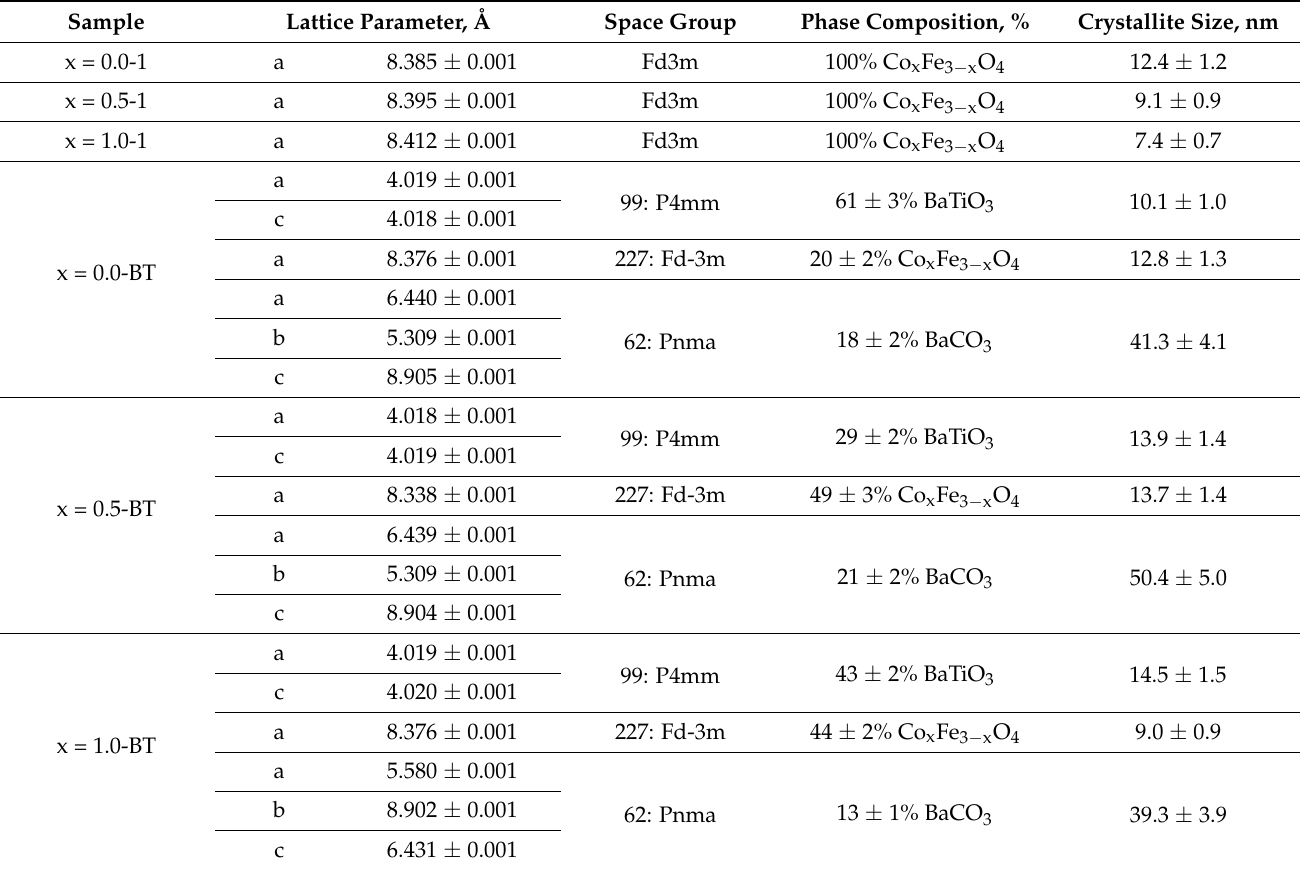
Table 1. XRD data for the synthesized samples.